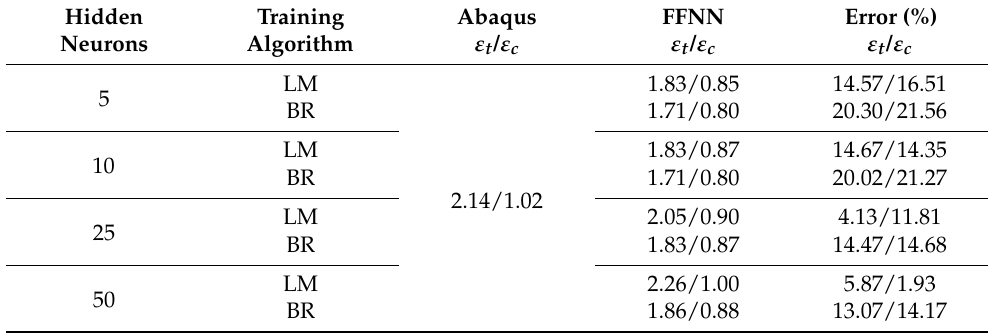
Table 7. Comparison between NN predictions and FEM results of FFNN2 with one hidden